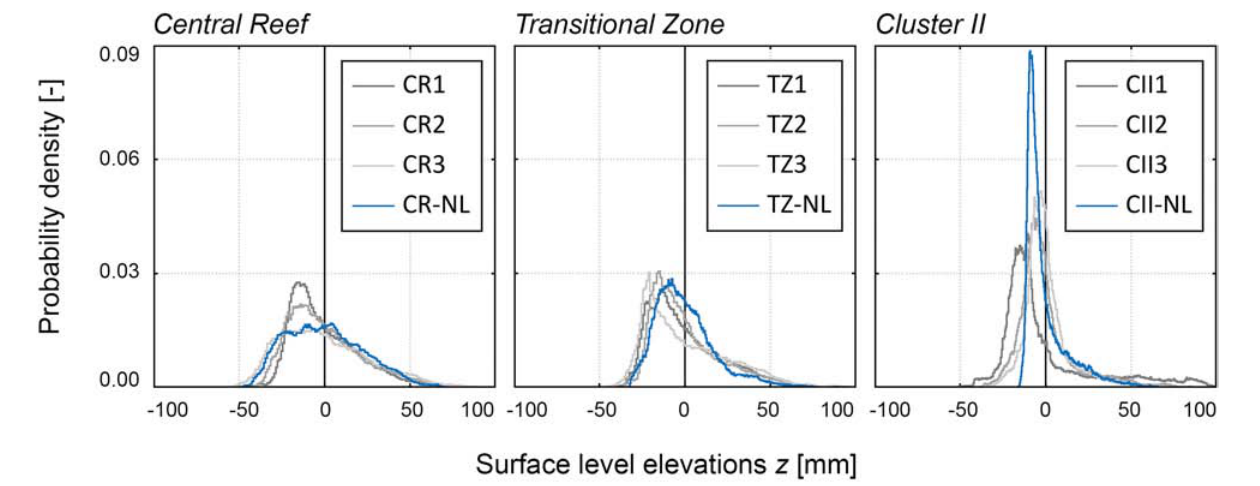
FIGURE 11 | Histograms based on surface level elevation z [mm] illustrating the PDFs [-] of the samples of Central Reef, Transitional Zone , and Cluster II including the validation samples recorded at the oyster Nordland . The PDFs are centered around the zero mean. The gray colors indicate the individual samples of Kaiserbalje as presented in Figure 5 and the blue color indicates the sample of Nordland , e.g., dark gray: CR1, medium gray: CR2, light gray: CR3, blue: CR-NL,